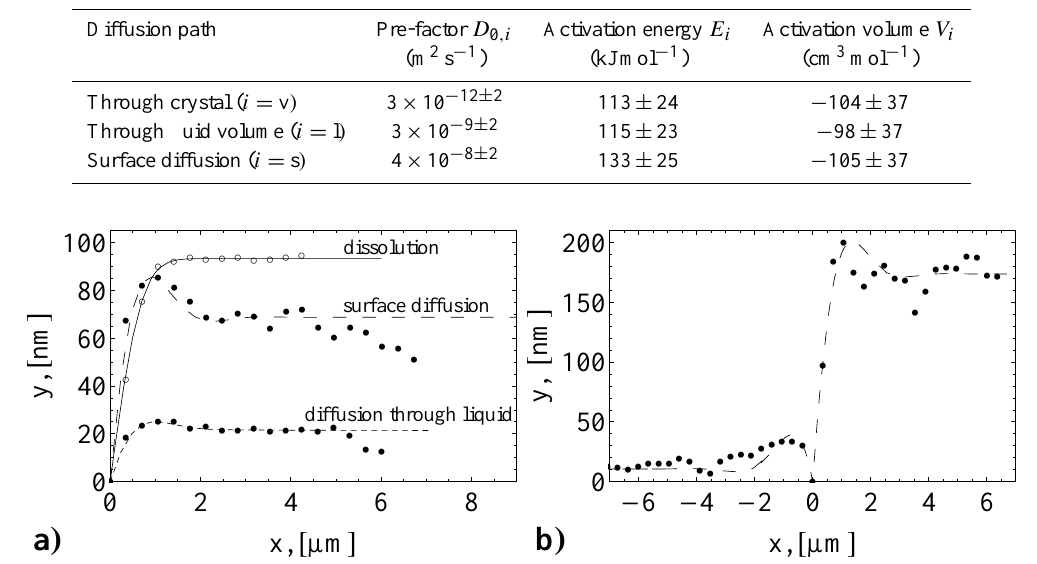
Table 3. Results from fit of growth law (3) to observations of d/ cot δ , employing the explicit formulations given in Table 1.